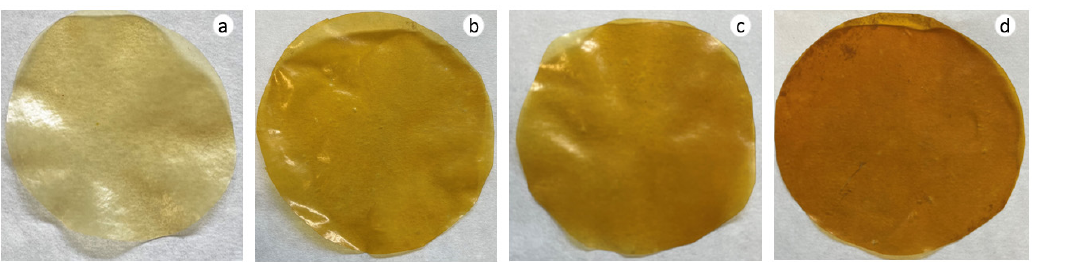
Figure 4. WPI film appearance as a function of ascorbic acid (AA) content: ( a ) 0 (Control), ( b ) 5, ( c ) 10, and ( d ) 15 wt% AA.